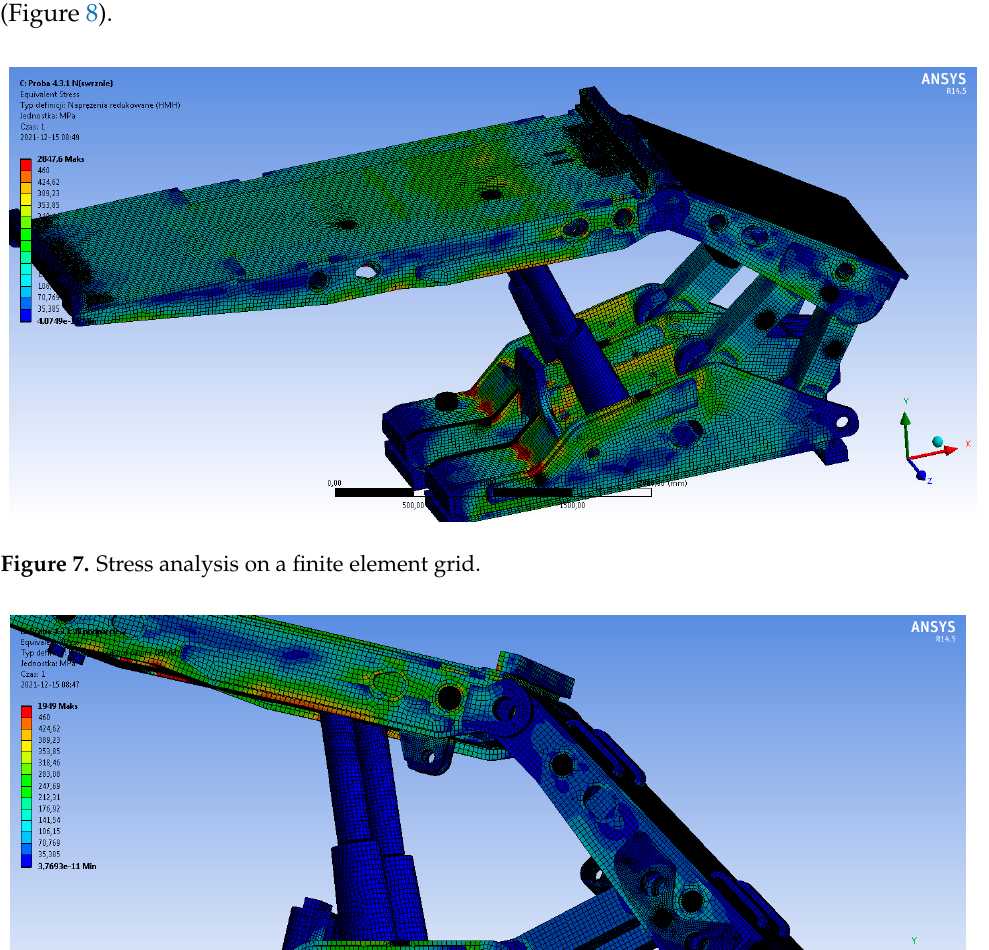
Figure 6. Load force simulation of the support’s canopy—correction.